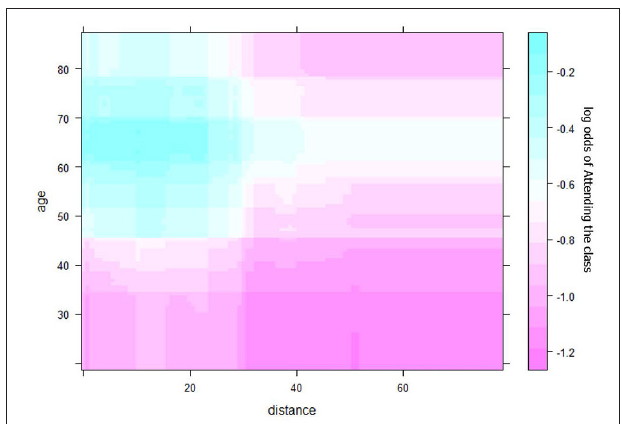
FIGURE 4 | Joint effect of age and distance on class attendance.